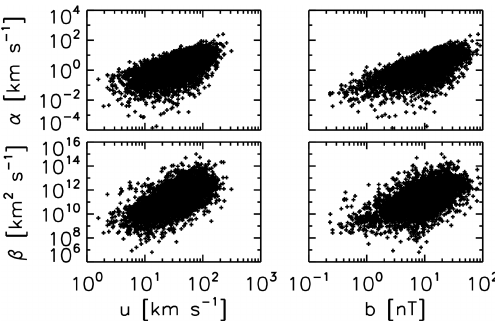
Figure 4. Transport coefficients α and β as functions of the fluctuat- ing flow speed and fluctuating magnetic field for the two-component electromotive force model with the α and β terms. The Helios solar wind data and the transport coefficients studied by Narita andVörös (2018) are used for the